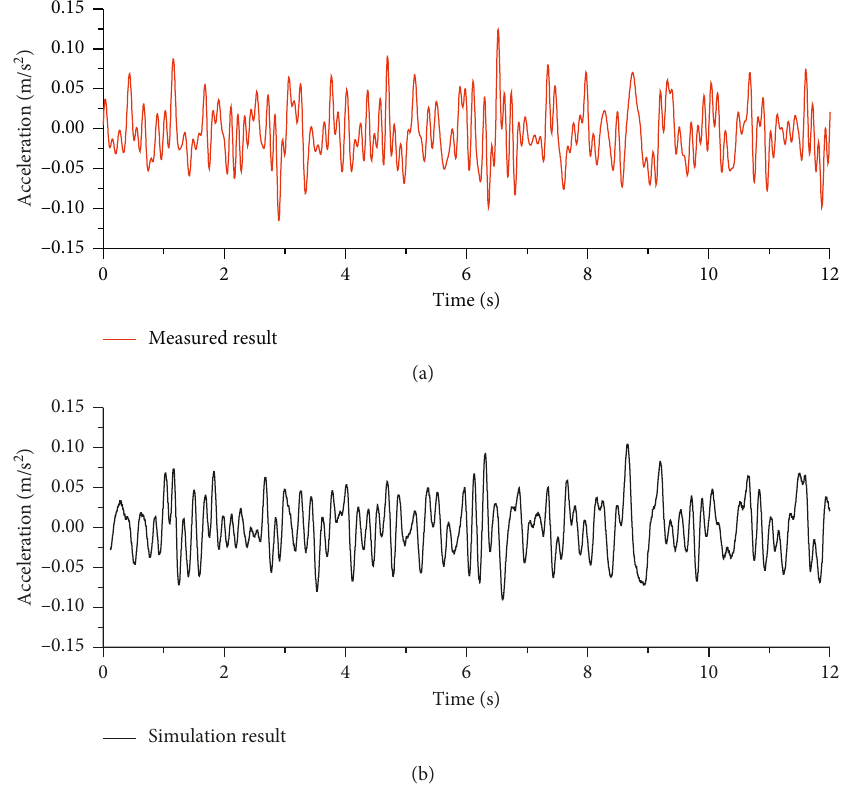
Figure 16: Vehicle accelerations. (a) Measured result. (b) Simulation result.